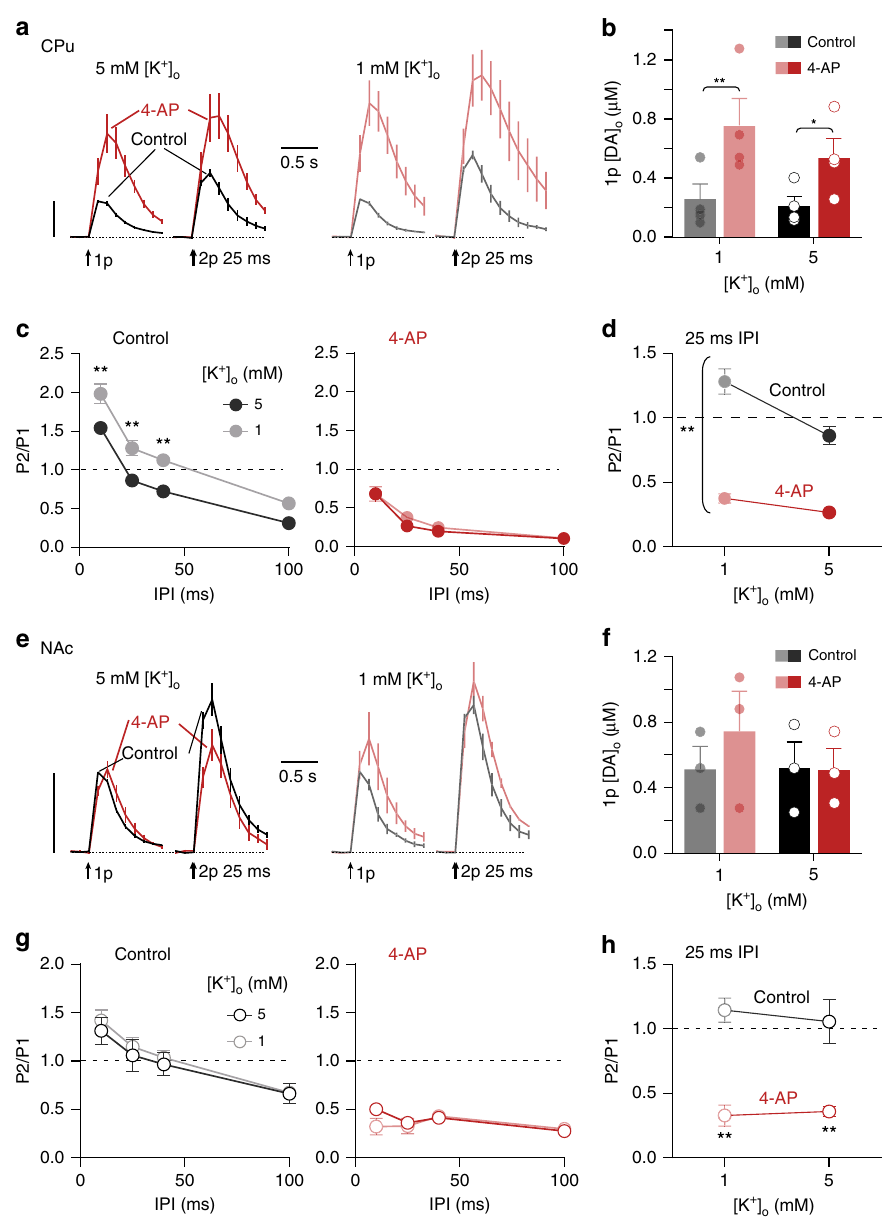
Fig. 4 K + -dependent gating of short-term depression requires axonal Kv channels. a , e Mean pro fi les of [DA] o transients in CPu elicited by single or paired electrical pulses in control conditions (black) or with 100 µ M 4-AP (grey) in CPu ( a , n = 4) and NAc ( e , n = 3). Data are normalised to peak 1p-evoked [DA] o (P1) in control conditions (vertical scale bars). b , f Mean 1p [DA] o (± SEM), and individual data points in CPu in 1 mM and 5 mM [K + ] o in control conditions (black/grey) or 4-AP (reds) in CPu ( b ) or in NAc ( f ). c , g Mean P2/P1 in CPu vs IPI in 5 mM (black) and 1 mM (grey) [K + ] o in control conditions (left) and 4-AP (right) in CPu ( c ) and in NAc ( g ). d , h Mean P2/P1 in CPu at 25 ms IPI in 1 mM and 5 mM [K + ] o in control conditions or 4-AP in CPu ( d ) and in NAc ( h ). d Asterisks indicate interaction between [K + ] o and 4-AP. Two-way ANOVA with Bonferroni ’ s test for post hoc comparisons; * P < 0.05, ** P < 0.01. Error bars are ± SEM. Source data are provided as a Source Data fi